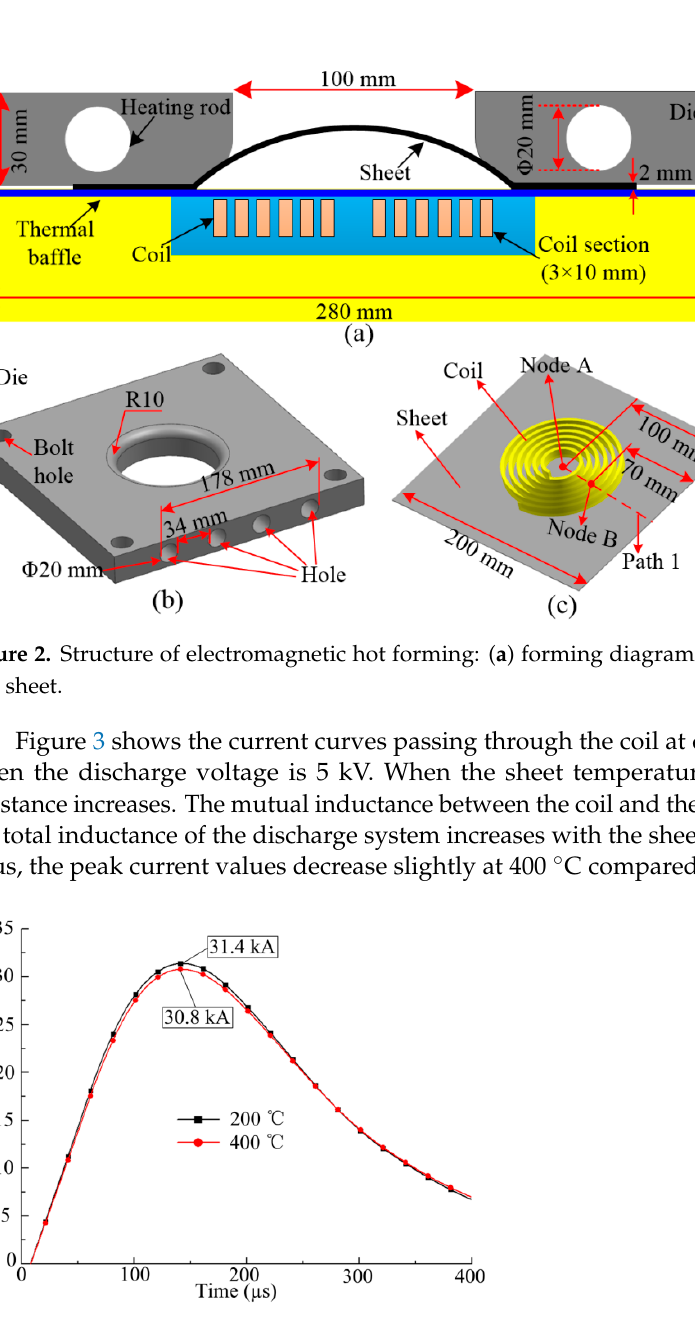
Figure 3. Current curve at 5 KV.